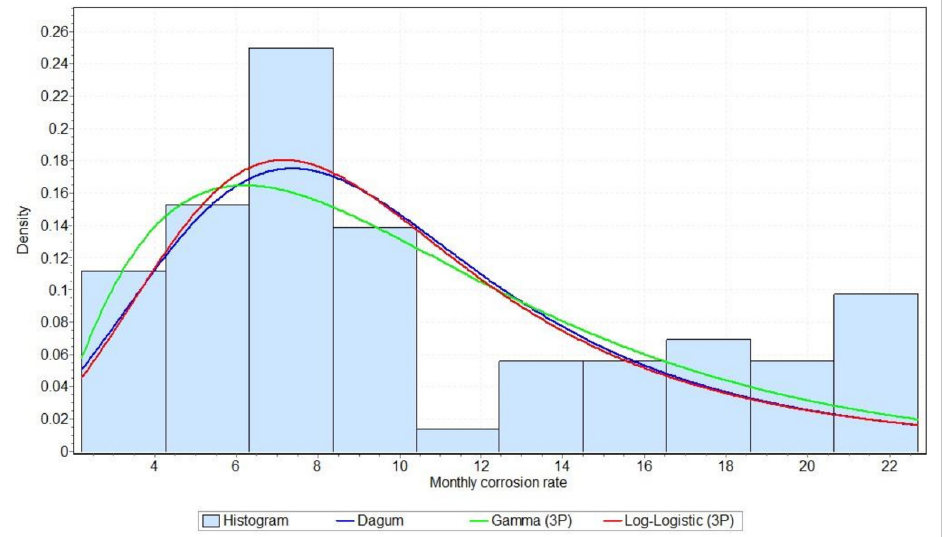
Figure 16. Empirical PDF and the three best fitted three-parameter distributions of the NiTi-2 alloy corrosion rate in a tidal